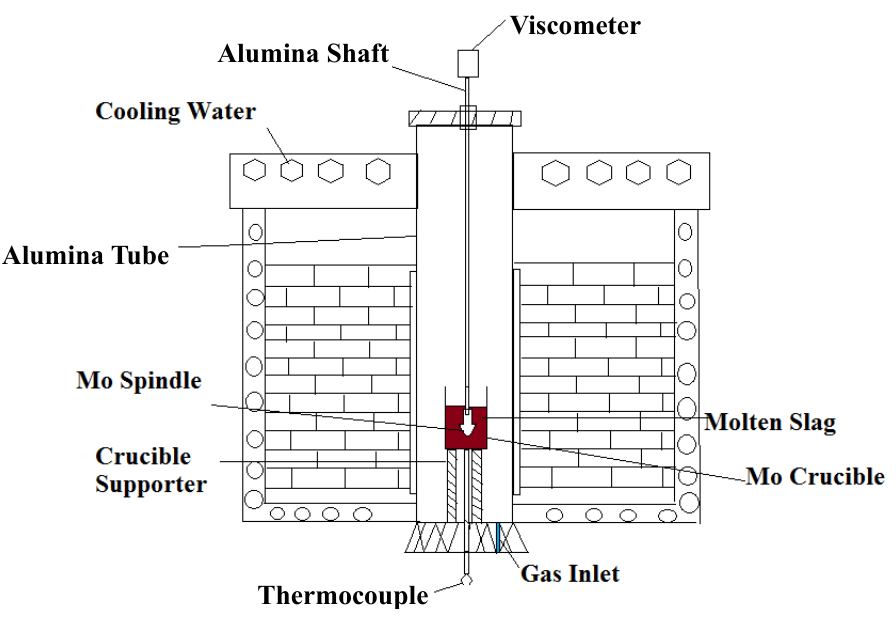
Figure 1. Experimental apparatus for measurement of slag